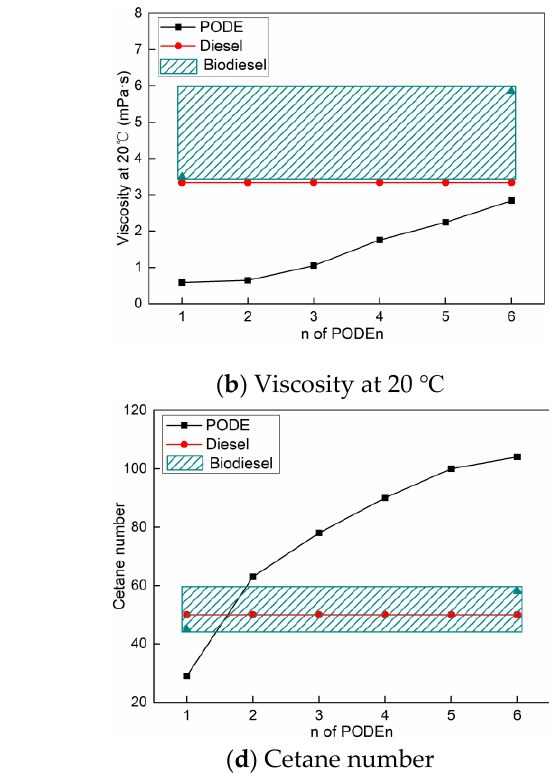
Figure 1. The main properties of PODEn, reproduced from References [6–13].